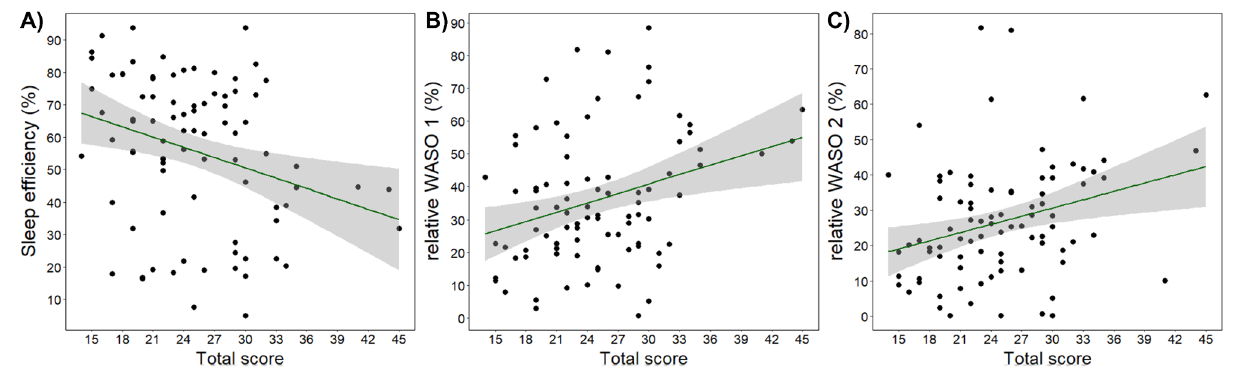
Figure 2. Visualization of Kendall’s rank correlations that showed significant associations between ADHD total score and ( A ) sleep efficiency ( τ b = −0.197, corr. p = 0.031), ( B ) WASO 1 ( τ b = 0.196, corr. p = 0.031) and ( C ) WASO 2 ( τ b = 0.223, corr. p = 0.031) after controlling for multiple correlations (Benjamini-Hochberg). Shaded areas indicate confidence